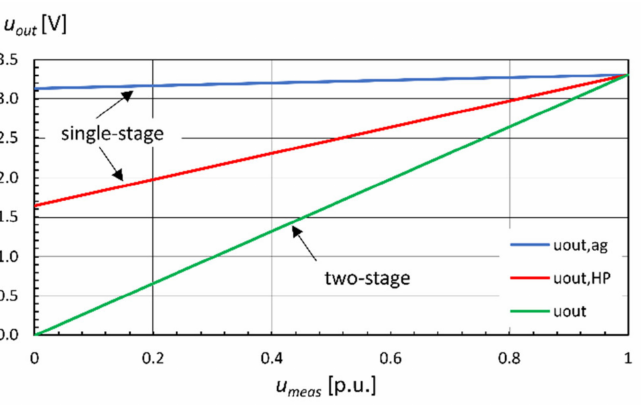
Figure 7. Input-to-output correlation for two measured voltages and amplifier